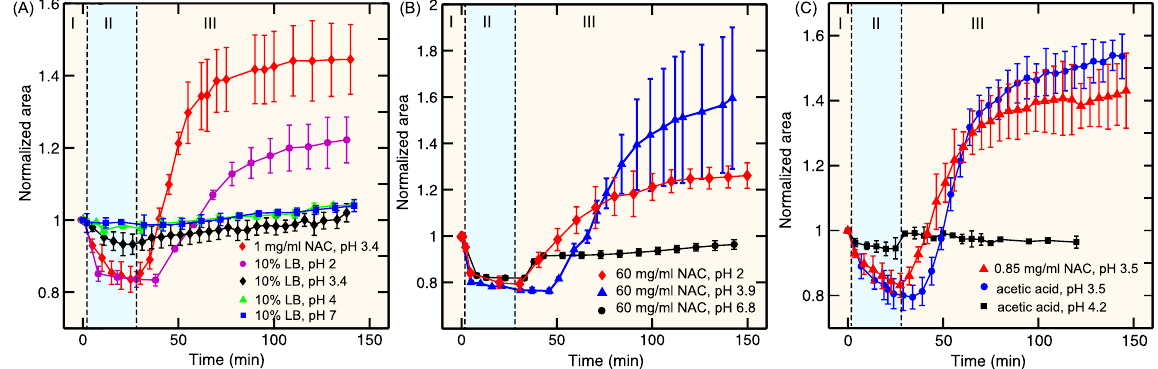
Figure 4. ( A ) Comparison of the effect of HCl and NAC on the killing of biofilm bacteria. The black and red curve compare the behavior of 1 mg/ml NAC (pH 3.4) and 10% LB with pH adjusted to 3.4 using HCl. No swelling at pH 3.4 without NAC indicates no killing of bacteria (confirmed with dead cell staining). ( B ) Effect of NAC with pH adjusted using sodium hydroxide on the killing of biofilm bacteria. The red curve shows the action of 60 mg/ml NAC in 10% LB. The blue and the black curves shows the effect of 60 mg/ml NAC with pH adjusted to 3.9 and 6.8 respectively. ( C ) Comparison of the effect of acetic acid and NAC on the killing of biofilm bacteria. Acetic acid and NAC at pH 3.5 lead to the swelling of the microcolonies. Acetic acid at pH 4.2 and above did not significantly affect the microcolonies.